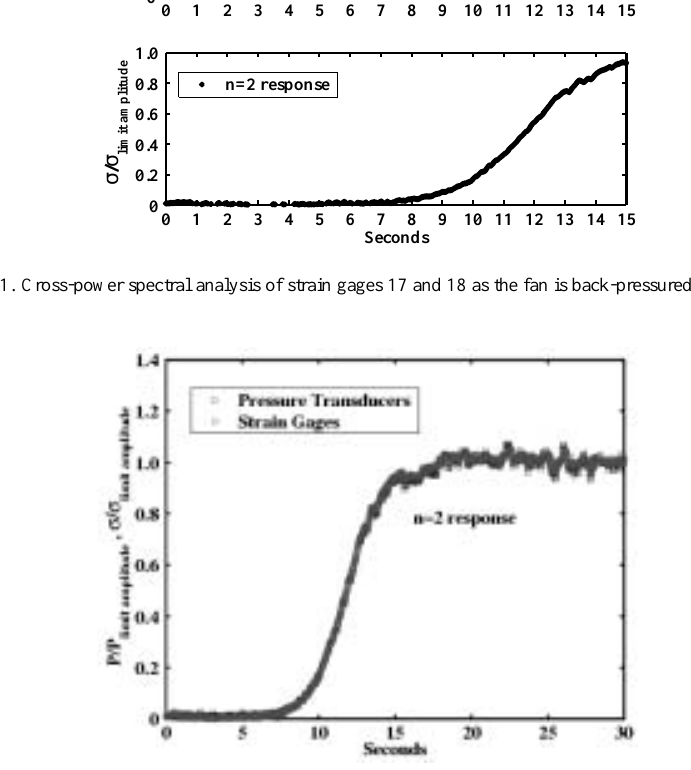
Fig. 12. Cross-power spectral analysis of strain gages 17 and 18 and pressure transducers 11 and 12 as the fan is back-pressured into flutter for n = 2 . one-dimensional spatial and two-dimensional space-time methods can not be easily employed. The two-dimensional space-time method was still effective for analyzing the data. To compensate, Lagrange interpolation was used to estimate the missing data for pressure transducers 6 and 13, see the